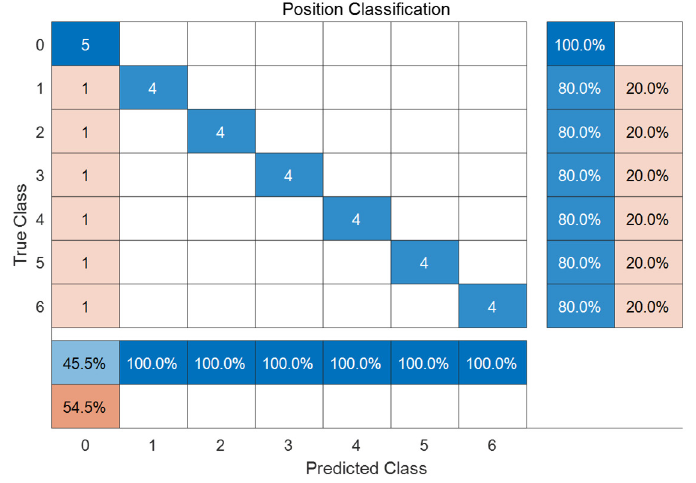
Figure 14. Damage identification by random forest algorithm.